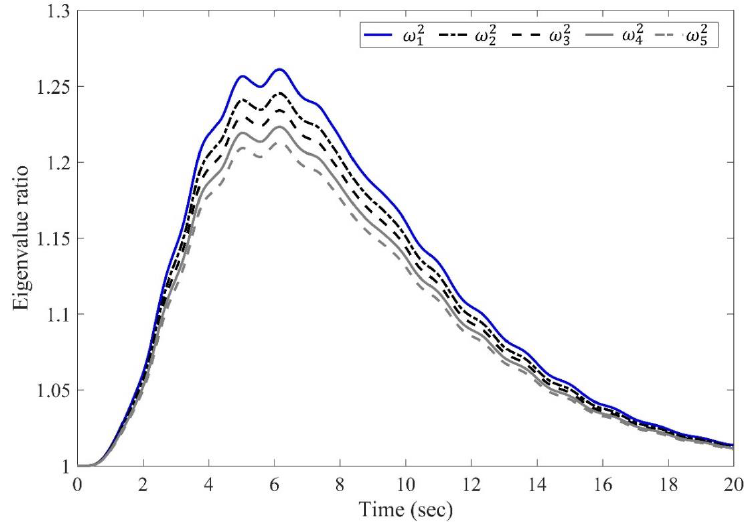
Figure 18. Variations of ratios of dynamic eigenvalues.